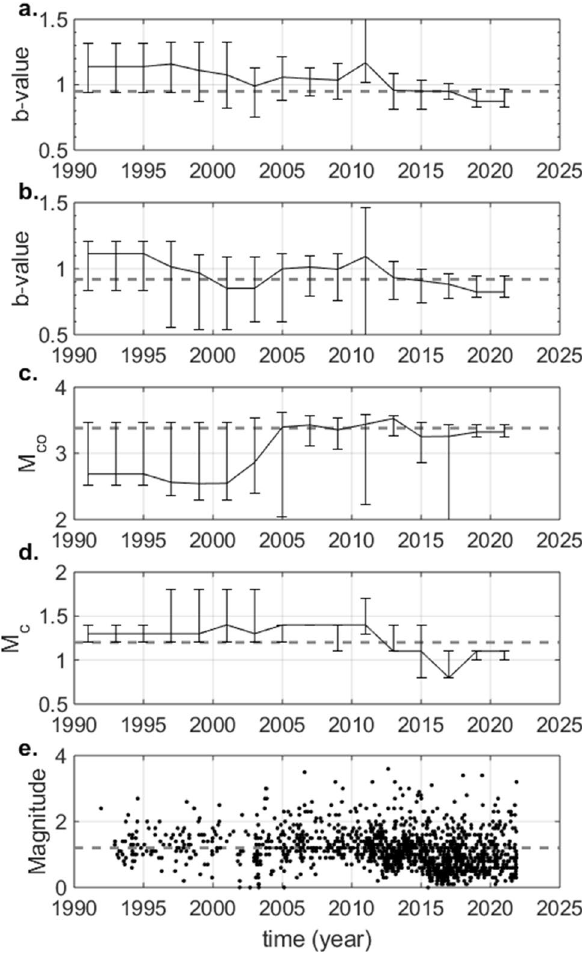
Figure 3. Result of the penalized likelihood-based analysis of possible temporal variations of the b -value in Groningen. ( a ) Temporal development of the b -value for the non-tapered solution. ( b ) Temporal development of the b -value of the tapered solution. ( c ) Temporal development of the corner magnitude of the tapered solution. ( d ) Temporal development of the magnitude of completeness. In ( a – d ) the error-bars denote the 5th to 95th percentiles range and the dashed line shows the value derived for the null-hypothesis of no temporal variations. ( d ) Magnitudes of the events in the catalogue plotted versus